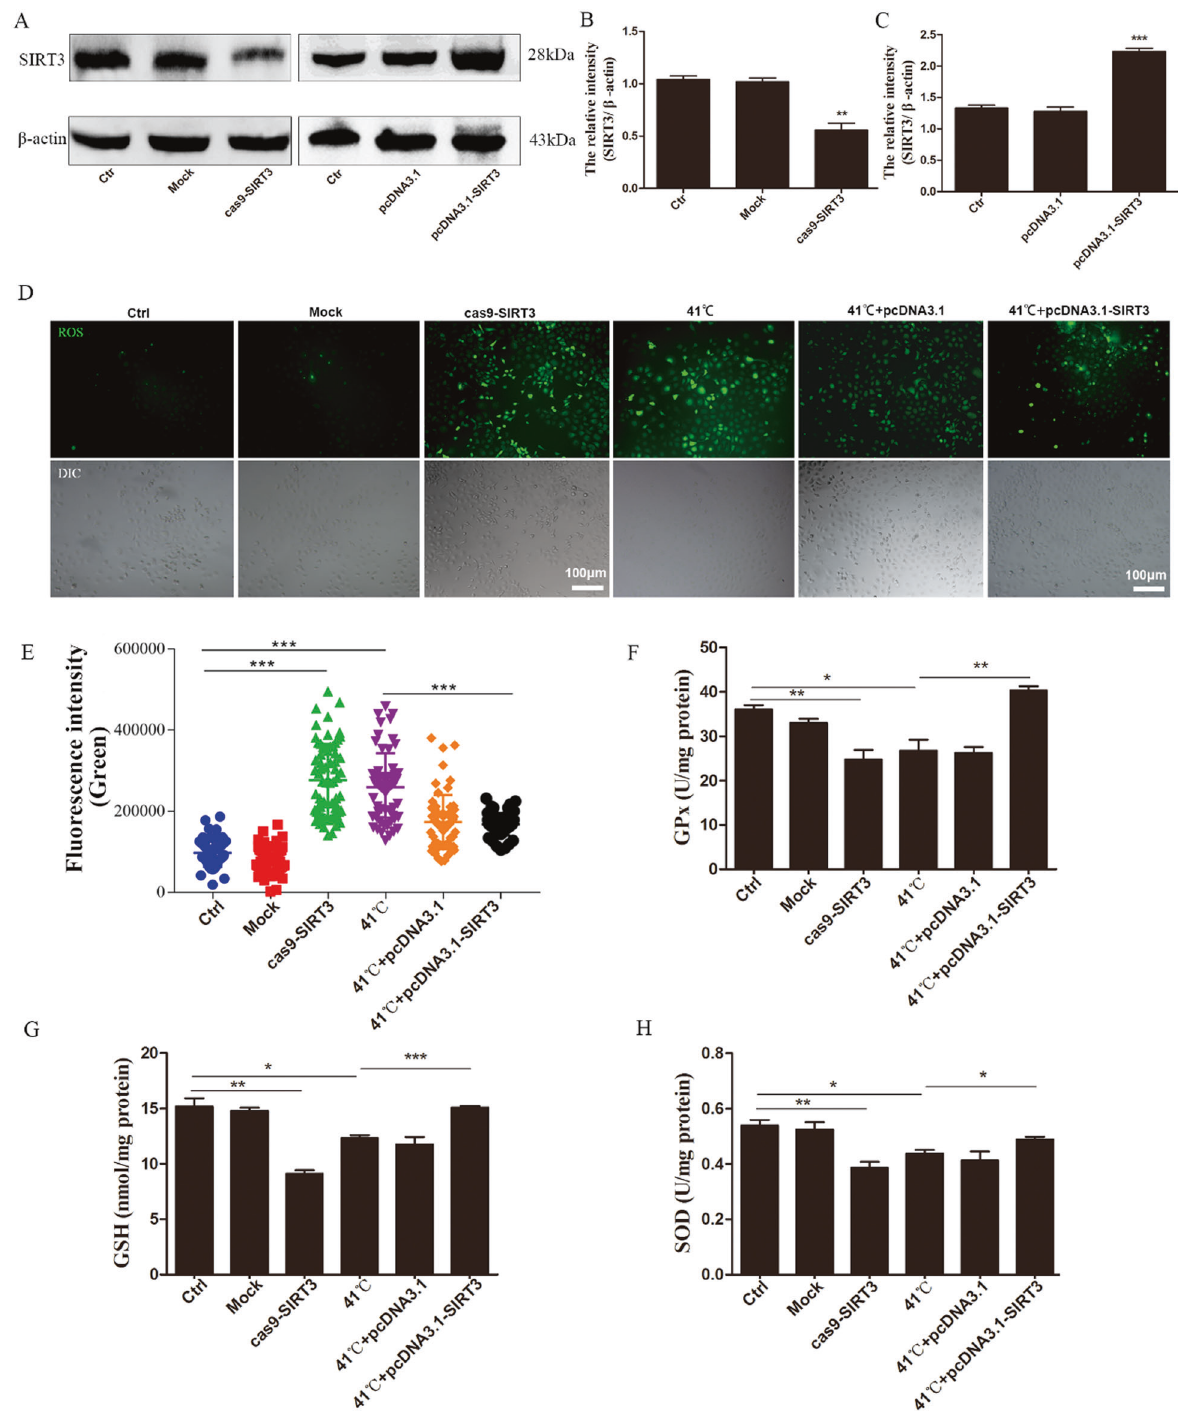
Fig. 2 SIRT3 regulates ROS production and oxidase activity in BMECs under heat stress. A – C The knockdown and overexpression ef fi ciency were evaluated using western blotting. D ROS is labeled with DCFH-DA. Scale bar: 100 µm, green: DCFH-DA. E The fl uorescence intensity of green positive cells was quanti fi ed using Image J. F – H Kits were used to determine cellular antioxidant enzyme content. Ctr cells are not transfected; Mock (negative control) means to transfect cells with empty plasmid; 41 °C means that cells are cultured at 41 °C; 41 °C + pcDNA3.1 (control) means to use empty vector pcDNA3.1 transfection cells; 41 °C + pcDNA3.1-SIRT3 cells were transfected with pcDNA 3.1-SIRT3. Data are expressed as mean ± S.E.M, * P < 0.05, ** P < 0.01, *** P < 0.001. inhibits the net ROS production of BMECs after high-temperature treatment, as well as stabilizes oxidative stress factors (GPx, SOD, and GSH) in BMECs. Further, ROS can alter the mitochondrial membrane potential. Decreased mitochondrial potential impairs